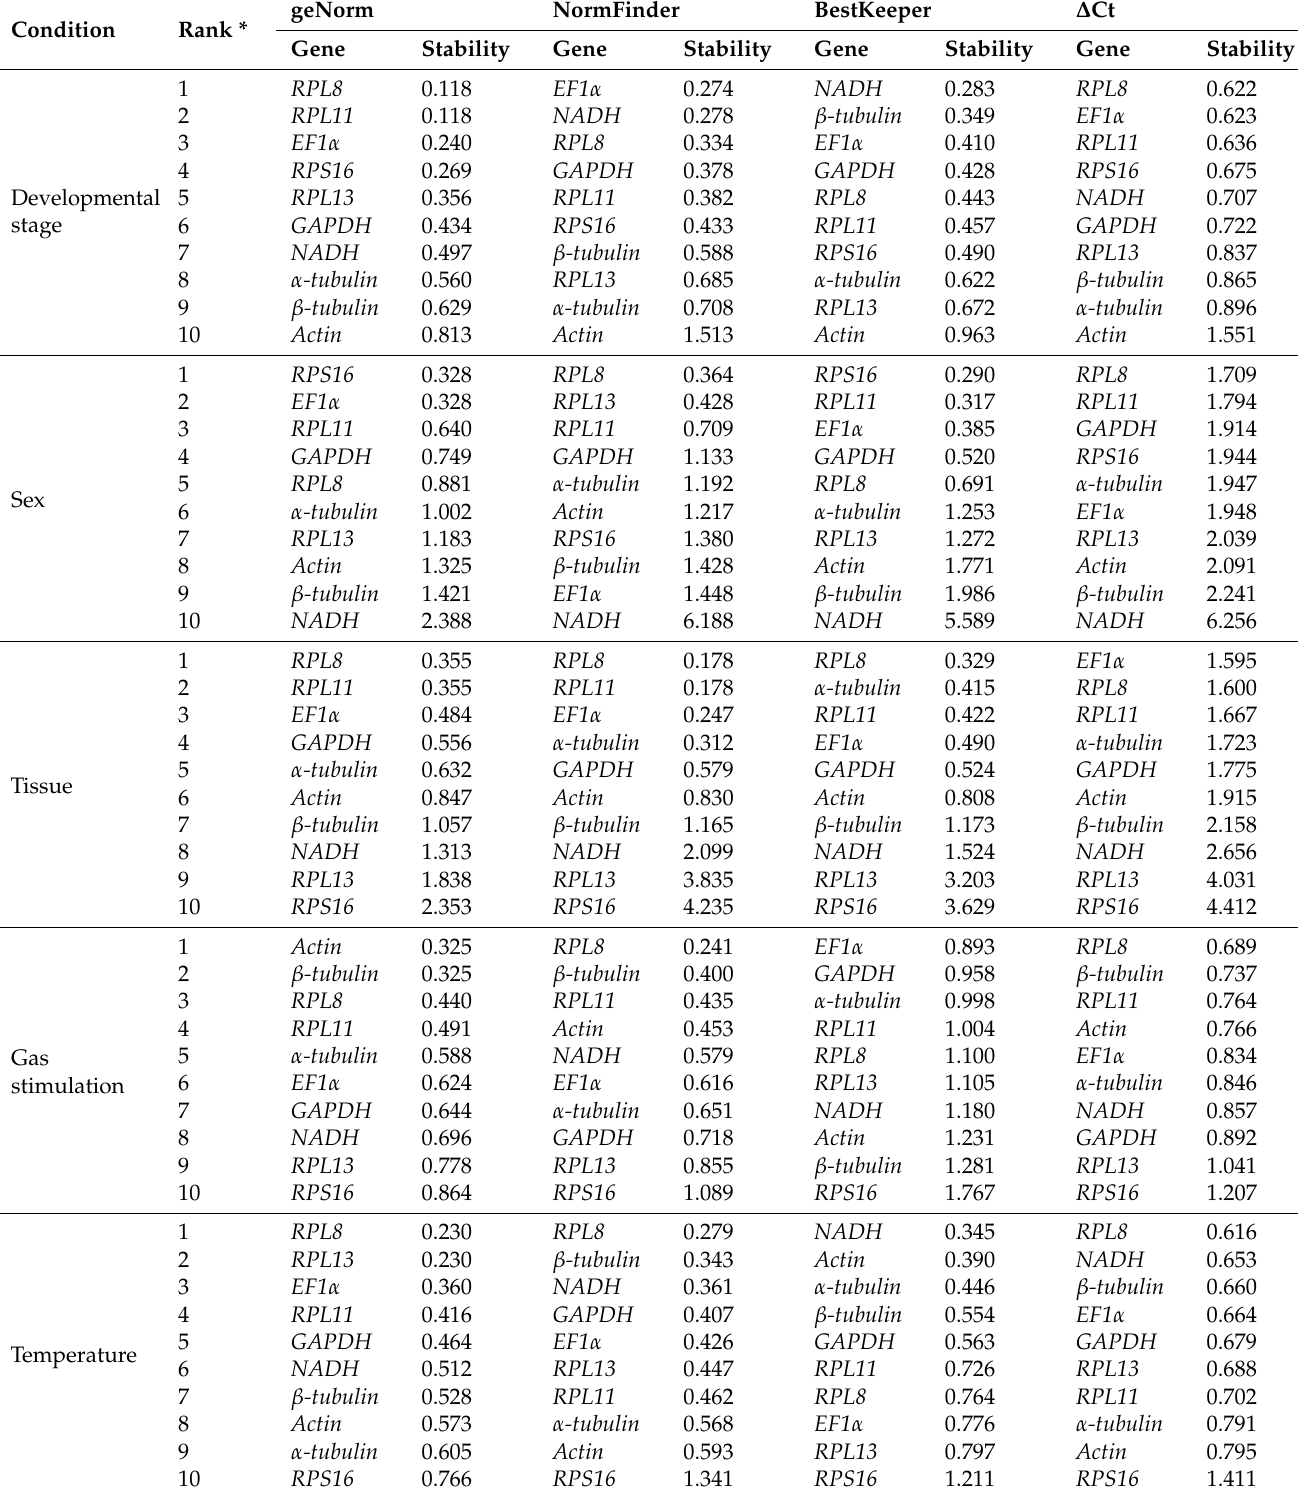
Table 3. Stability of 10 reference genes in Cimex hemipterus under different